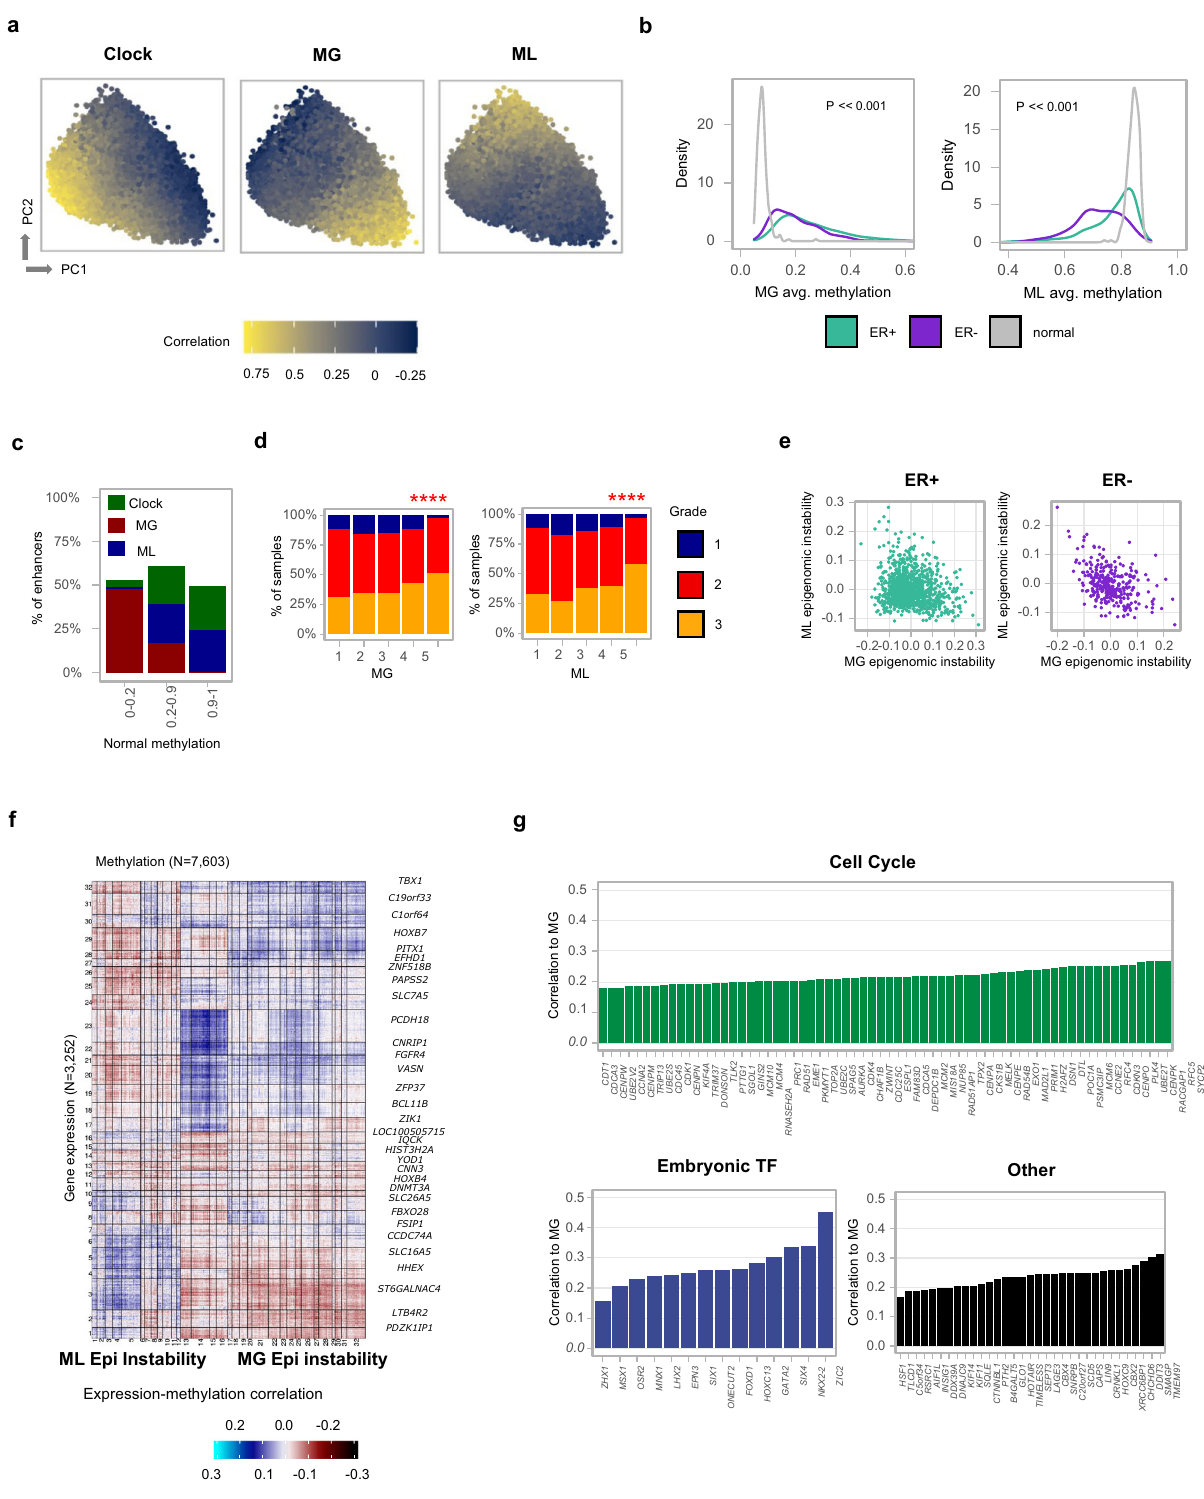
Fig. 2 Epigenomic instability in breast cancers. a Color-coded maps represent 201,082 genomic loci projected over the two fi rst principal components given their correlations with the three Methylayer scores. b Distribution of average (non-normalized) methylation over MG and ML loci (correlation over 0.5 with each score) for normal breast, ER + and ER − breast cancer samples (two-tailed Kolmogorov – Smirnoff test: MG loci, p < 2.2e − 16; ML loci, p < 2.2e − 16). c Fraction of enhancers (grouped by their normal methylation level) that are linked (correlation > 0.25) with each of the three Methylayer scores. d Distribution of ER + tumor grade strati fi ed by fi ve bins of MG/ML methylation scores. **** p < 0.0001 ( χ 2 test: MG loci, p = 0.000002; ML loci, p < 5.4e − 10). e Comparing ML and MG scores over ER + and ER − samples. f Clustered correlation heat map between normalized methylation pro fi les (columns, including all loci with correlation >0.3 for MG or ML) and matching gene expression (rows) in ER + tumors. Clusters are labeled by their top correlated gene. Complete information is available in Supplementary Data 4. g Groups of genes showing positive expression correlation with the MG score (see Supplementary Data 6. Complete information for ML score is also available in this